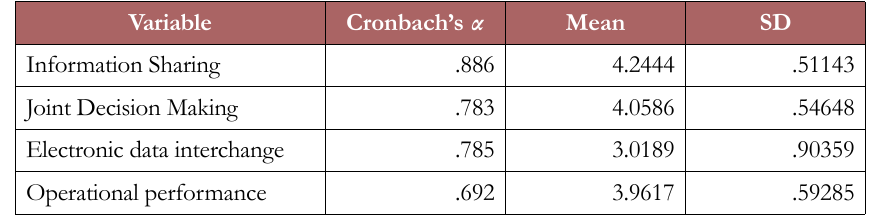
coefficient, means and standard deviations